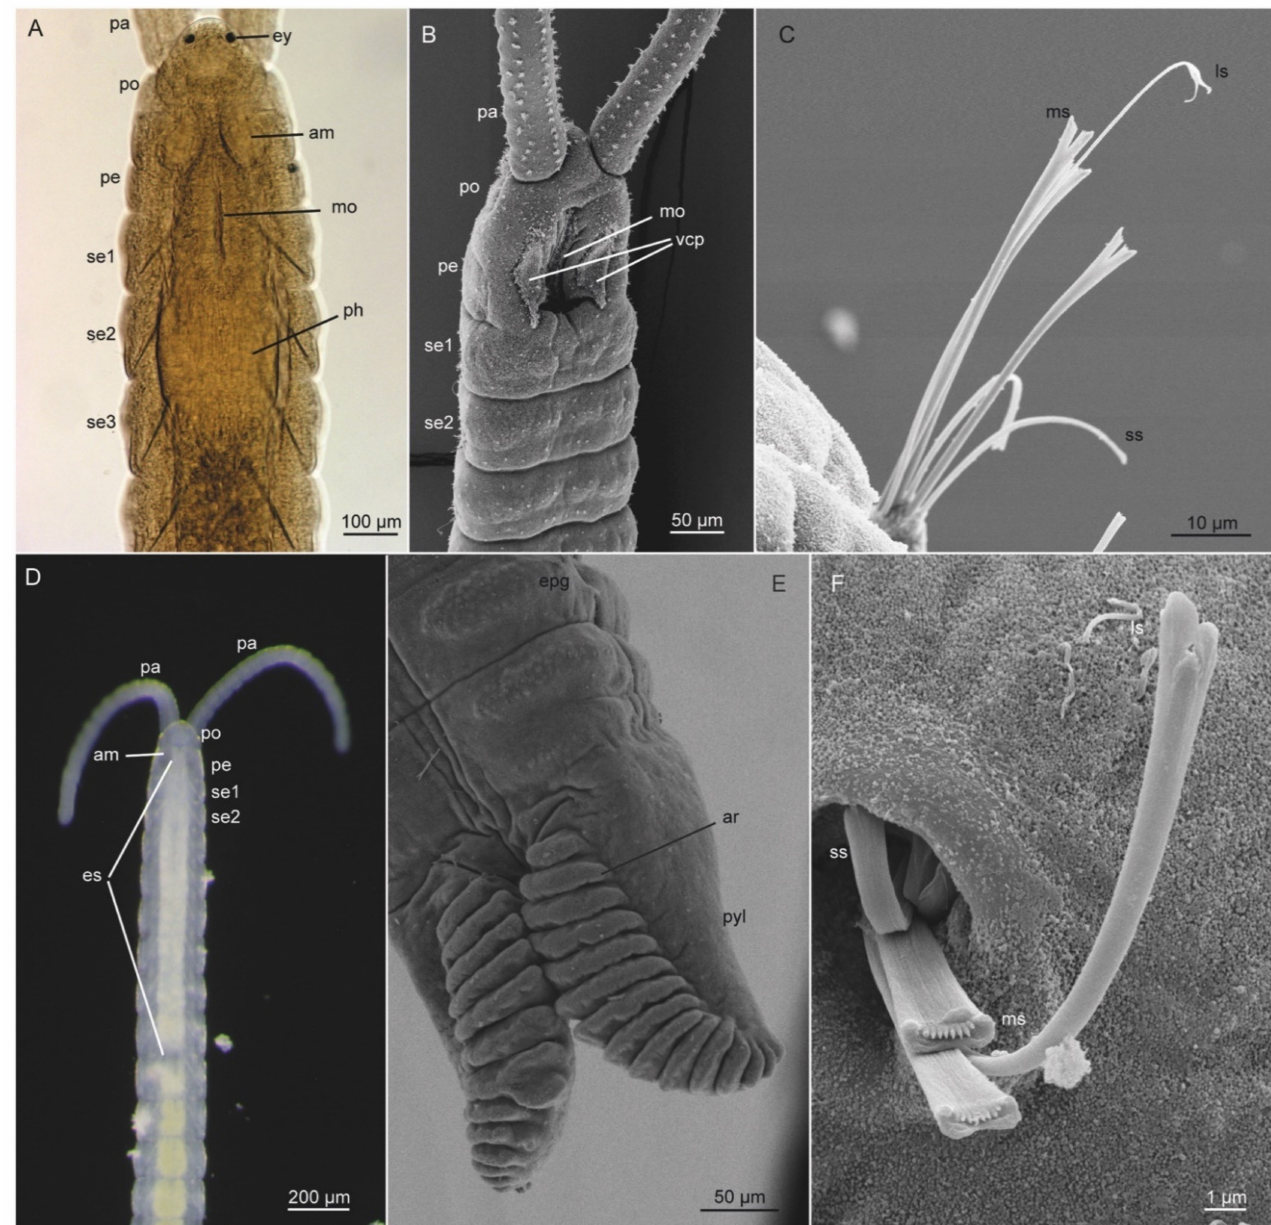
Figure 16. Morphology of Saccocirridae. ( A – C ) Pharyngocirrus. ( D – F ) Saccocirrus . ( A ) Light microscopy of Pharyngocirrus sp. (Bocas del Toro, Panam á ). ( B ) Scanning electron micrograph of Pharyngocirrus sp. (Bird Rock, CA, USA). ( C ) Scanning electron micrograph of Pharyngocirrus sp. (Bocas del Toro, Panam á ). ( D ) Light microscopy of Saccocirrus sp. (Bermuda), dorsal view. ( E ) Saccocirrus slateri (Abades, Tenerife, Canary Island). ( F ) Saccocirrus sp. (Mala, Lanzarote, Canary Island). Abbreviations: am, ampullae; ar, adhesive ridges; epg, epidermal adhesive glands; es, esophagus, ey, eye (ocellus); ls, longest setae; mo, mouth opening; ms, medium setae; pa, palps; pe, peristomium; ph, pharynx; po, prostomium;